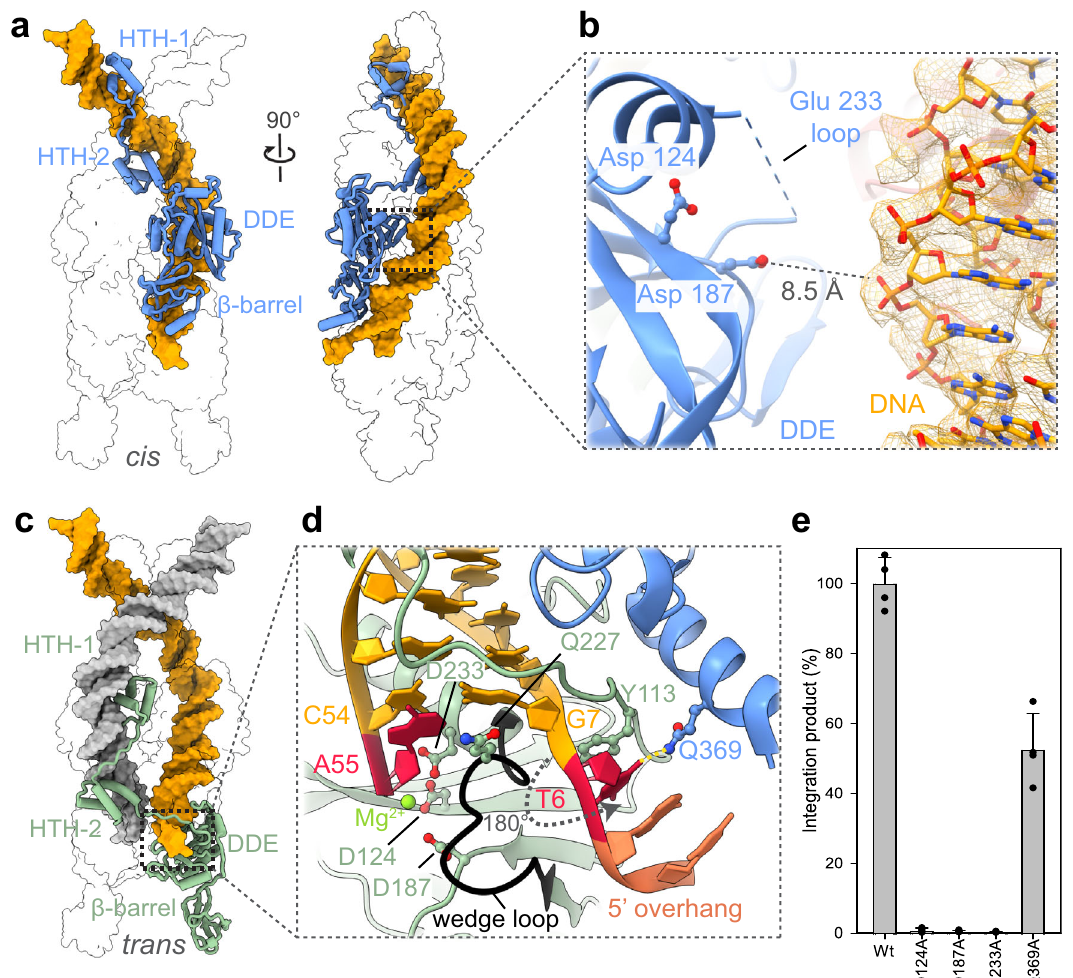
Fig. 5 | The IstA tetramer is formed by two structural and two catalytic sub- units.a Twoorthogonalviewsofoneoftheuppermonomers(chainC)bindingthe transposon end in cis . Only one transposase molecule isshown for clarity. b Close- up view of the boxed area highlighted in ( a ). Density of the DNA is contoured at a threshold value of 0.0245. Two acidic catalytic amino acids of the DDE fold are shownasball-and-stick. c Thecatalytic monomersinteractwith DNAends in trans . OnlychainAisshownforclarity. d DetailedviewoftheIstAactivesite.ChainsAand C are shown (green and blue, respectively). The DDE motif and some residues critical for the interaction with the DNA are depicted as balls and sticks. A well-